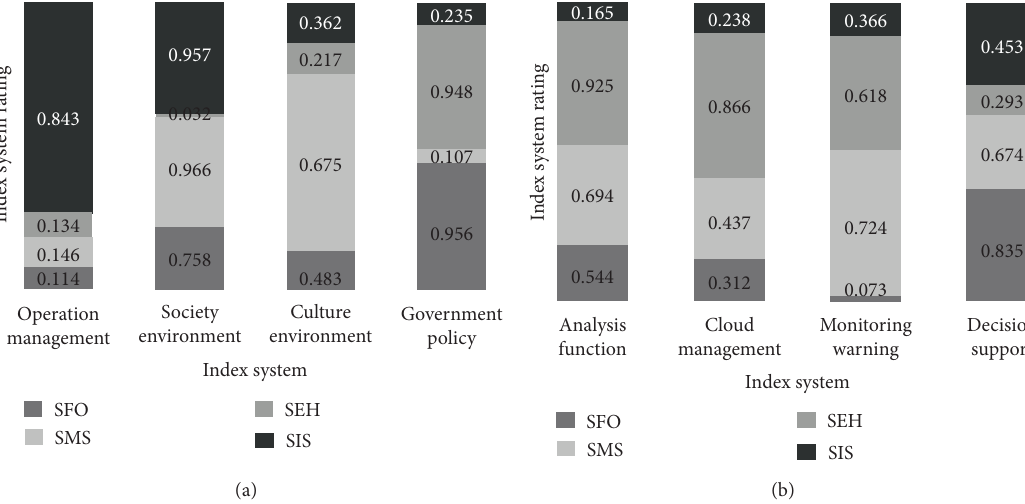
Figure 8: Index system rating of the resource scheduling (a) and strategic management (b) of smart city based on digital economy. SFO, smart foundation operation; SMS, smart management services; SHE, smart economy and humanity; SIS, smart integrated